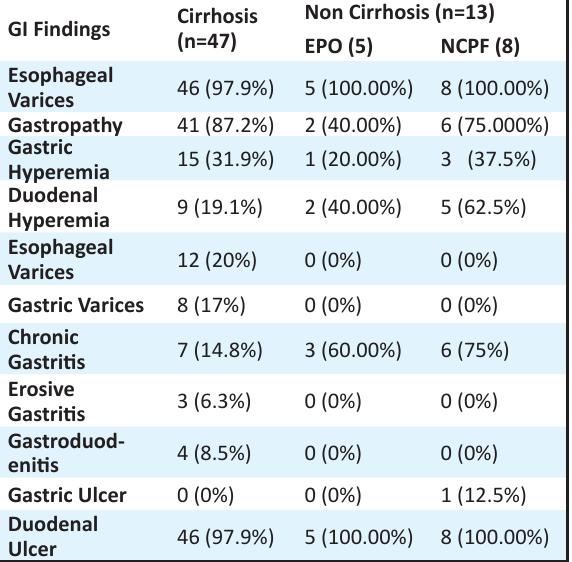
Table 3. Upper gastrointestinal endoscopic observation in portal hypertension.